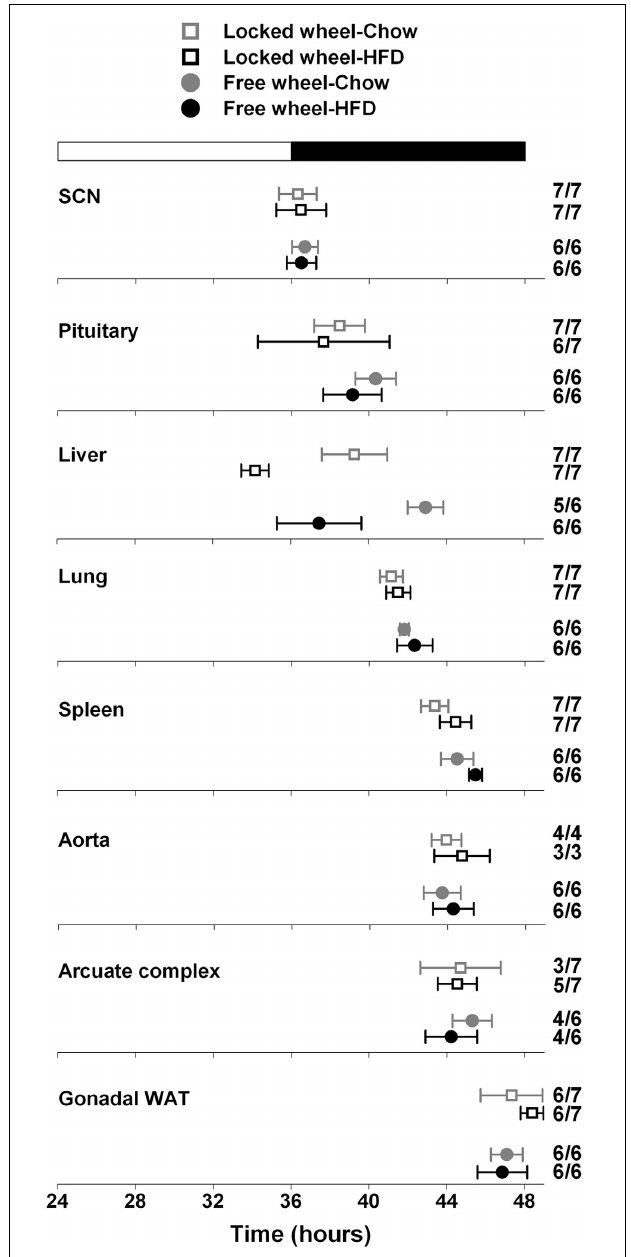
FIGURE 2 | Wheel-running activity affects the phase of the liver clock. Male heterozygous PER2::LUC mice were single-housed in cages with either locked (open squares) or freely rotating (filled circles) running wheels. Mice were fed chow (gray symbols) or HFD (black symbols) for 1 week. The mean ( ± SD ) phases were determined from the peaks of PER2::LUC expression during the interval between 12 and 36h in culture and were plotted relative to the time of last lights on where 24h is lights on and 36h is lights off (white and black bar at top). The sample size is shown (number of rhythmic tissues/number of tissues tested). Locked wheel data is taken from Pendergast et al. (2013). There were main effects of wheel on the phases of the lung [ F ( 1 , 22 ) = 9 . 22, p = 0 . 006], liver [ F ( 1 , 20 ) = 30 . 72, p < 0 . 001], and spleen [ F ( 1 , 21 ) = 15 . 29, p < 0 . 001] and main effects of diet on the phases of the liver ( F = 71 . 25, p < 0 . 001) and spleen ( F = 13 . 14, p = 0 . 002). There was no effect of an interaction between wheel and diet on the phase of any